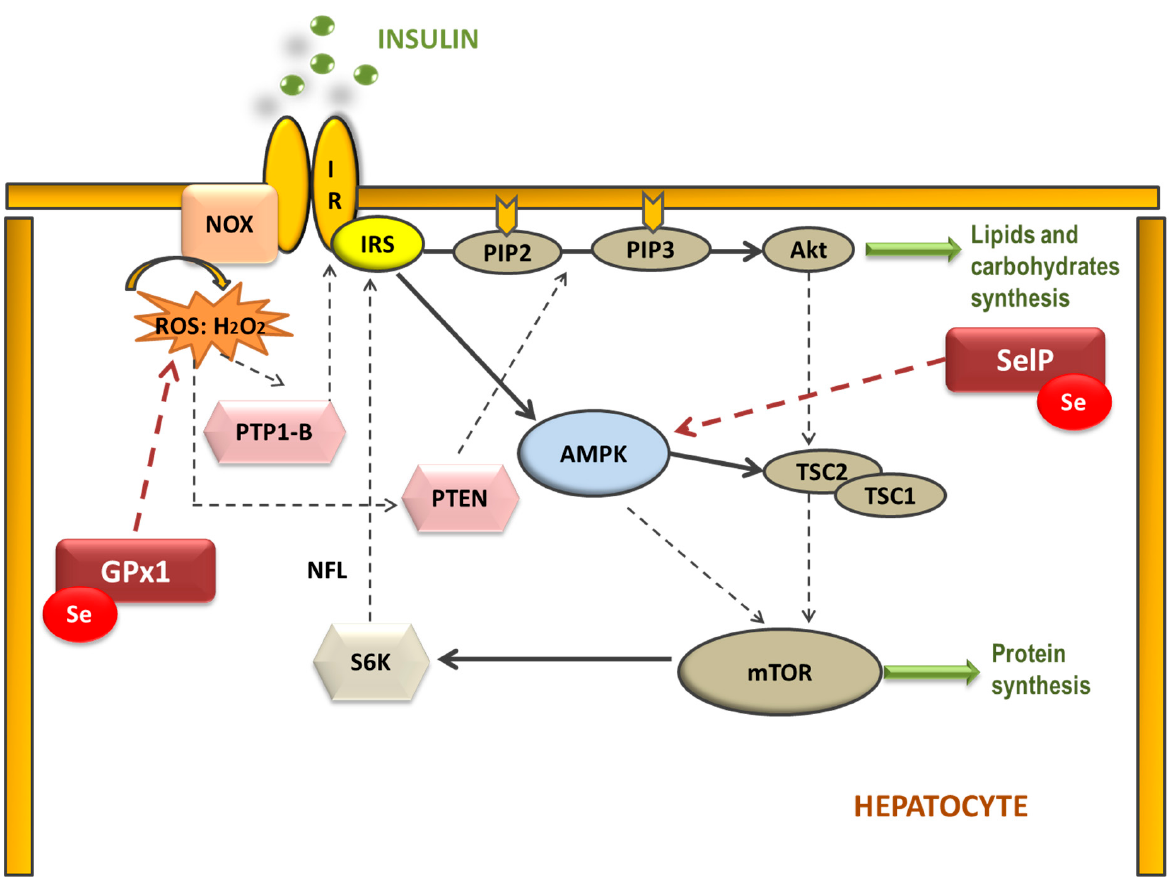
Figure 1. Selenoproteins’ possible implication in the hepatic insulin signaling pathway. The bind- ing of insulin to the insulin receptor (IR) triggers consecutive phosphorylation (P) of downstream signaling molecules, resulting in activation of Akt. Additionally, NADPH oxidase (NOX)-mediated ROS production is stimulated by insulin. Reduction of H 2 O 2 by GPx1 may attenuate insulin sig- naling, as H 2 O 2 is required to inactivate the insulin counter-regulatory phosphatases PTP-1B and PTEN. Moreover, SelP could inhibit adenosine monophosphate-activated protein kinase (AMPK), a metabolic energy sensor, which negatively regulates protein synthesis through the inhibition of the mammalian target of rapamycin (mTOR)-S6 kinase (S6K) pathway, which also modulates IRS phosphorylation. (IRS: insulin receptor substrate; PIP2: phosphatidylinositol 4,5-bisphosphate; PIP3: phosphatidylinositol 3,4,5-trisphosphate; TSC1 and 2: tuberous sclerosis complex 1 and 2). OS is a state of negative imbalance between the excess of pro-oxidative compounds